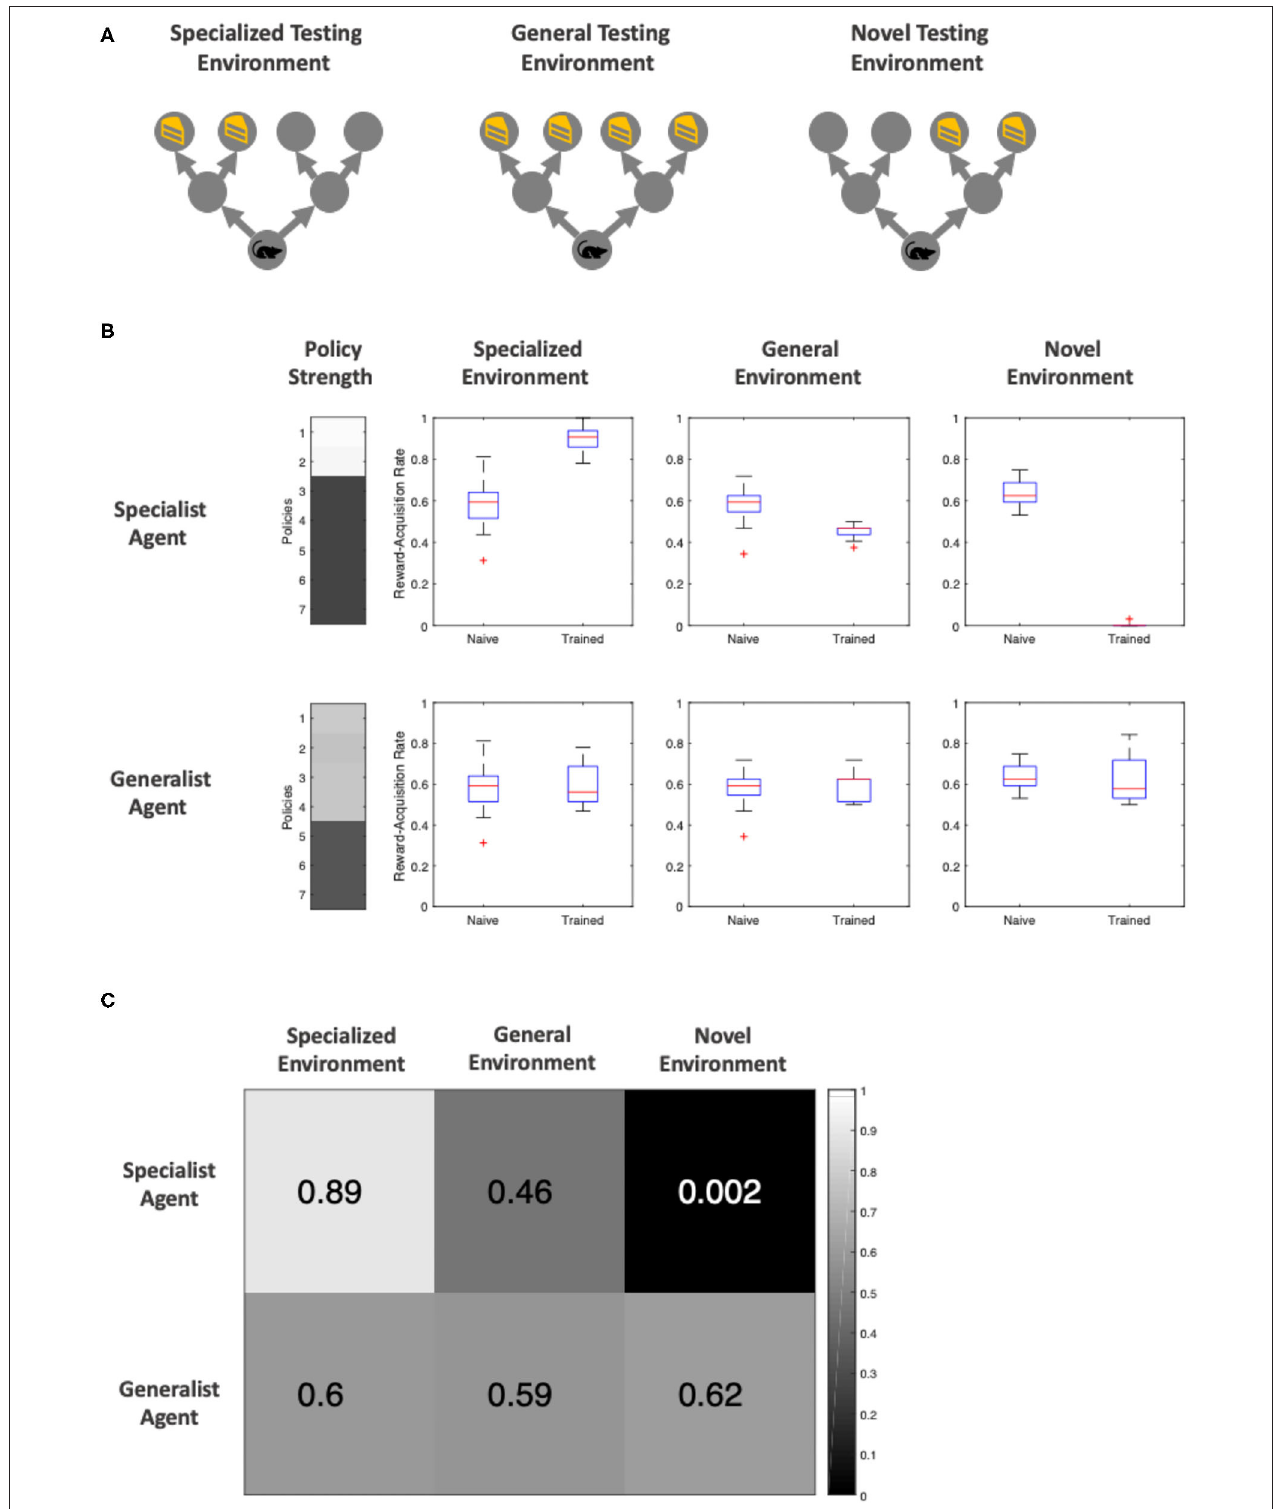
FIGURE 6 | Post-training performance of specialist and generalist agents in ambiguous environments (the agent is 65% sure it sees the cue telling it to go in the correct direction) (A) Visualization of the three testing environments. The specialized and general testing environment have identical reward location and